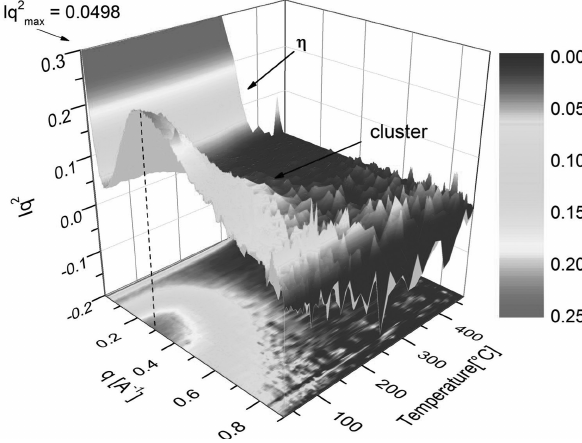
Figure 2: The Kratky plot (Iq2 versus q) as a function of temperature for the fastest quench (FQ). The Iq2 scale in the Kratky plot was set to a value of 0.3 in order to better observe the evolution for high values of the scattering vector